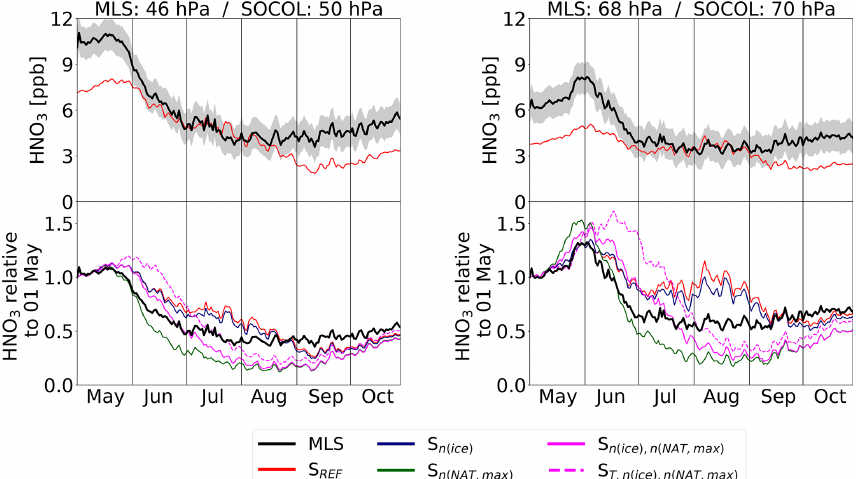
Figure 7. Temporal evolution of polar (60–82 ◦ S) mean gas-phase HNO 3 from MLS measurements and the different model simulations. The uncertainty range (gray shading) represents the MLS